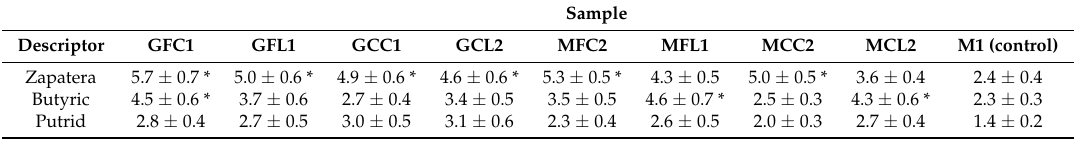
Table 4. The intensity ratings for the sensory spoilage descriptors of olive